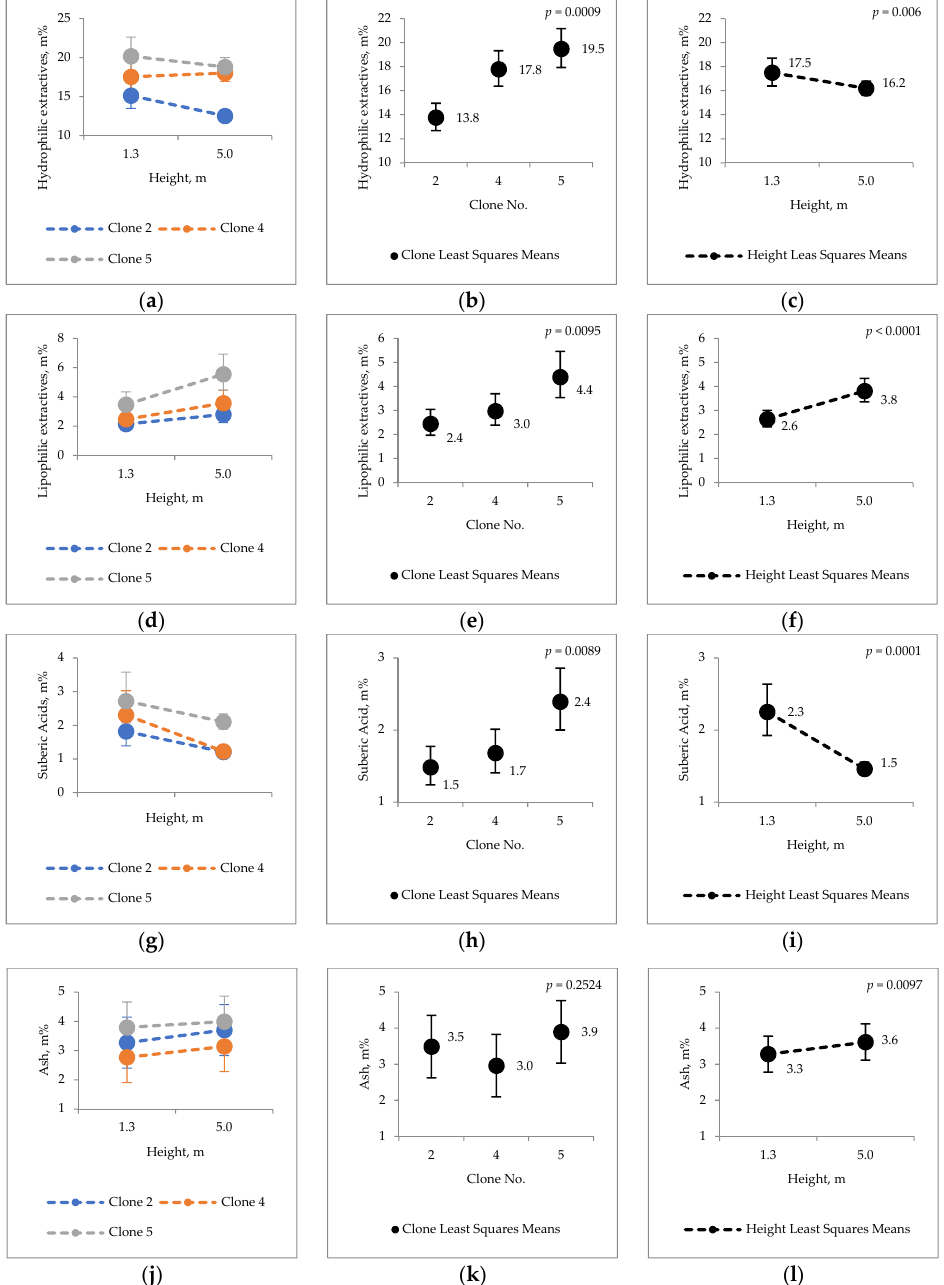
Figure 2. Content of ( a – c ) hydrophilic extractives; ( d – f ) lipophilic extractives; ( g – i ) suberic acid and ( j – l ) ash.